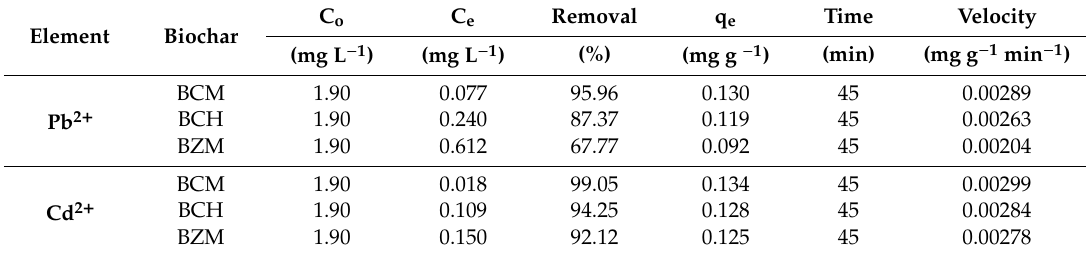
Table 3. Comparison of the adsorption results obtained for the biochar.